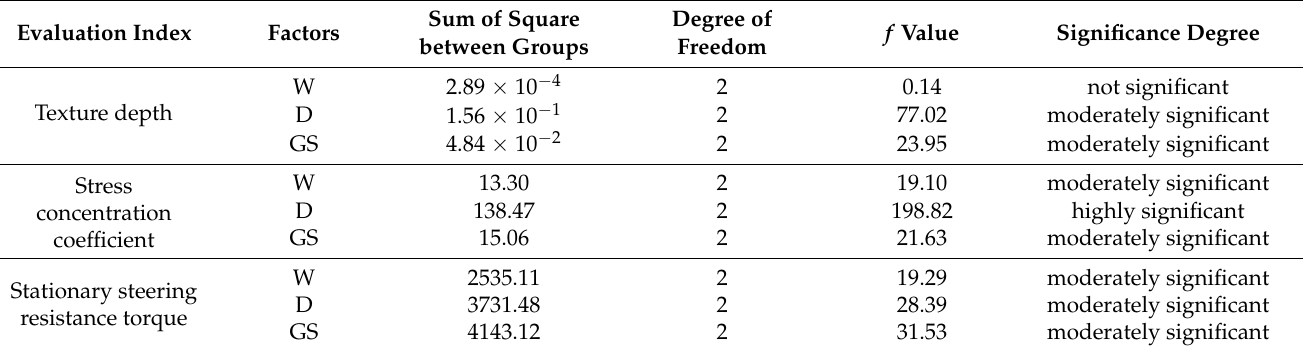
Table 7. Analysis of variance